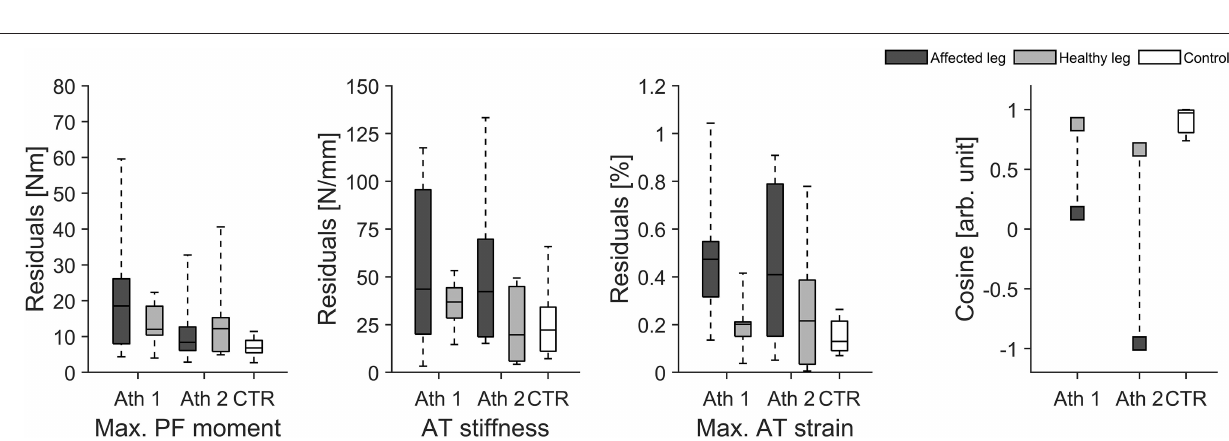
tendon stiffness in their affected (injured) limb compared